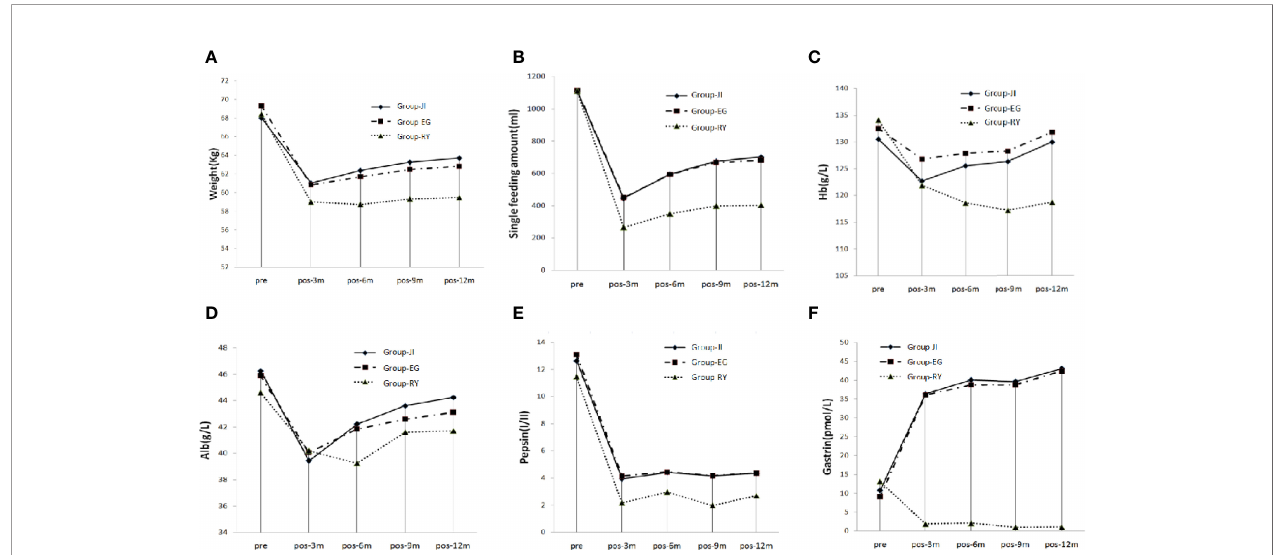
FIGURE 3 | Nutrition Index. (A) Single food intake. (B) Body weight. (C) Hemoglobin. (D) Albumin. (E) Pepsin. (F)